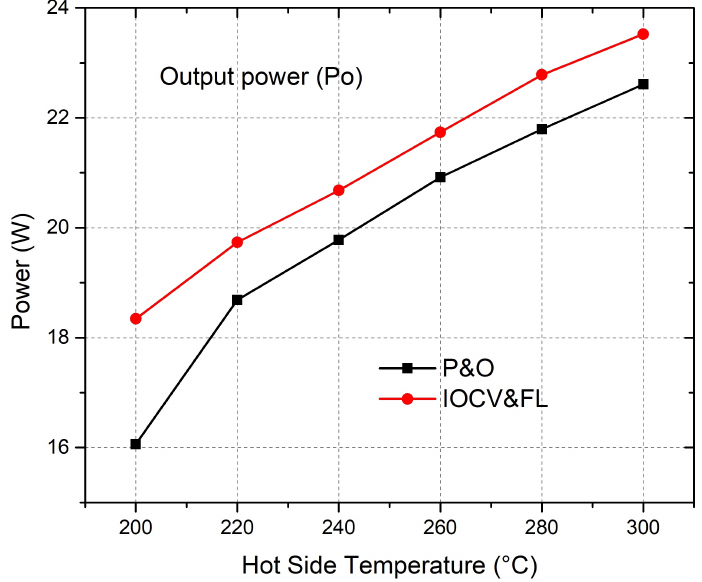
Figure 14. Output power plot at different hot-side temperatures.